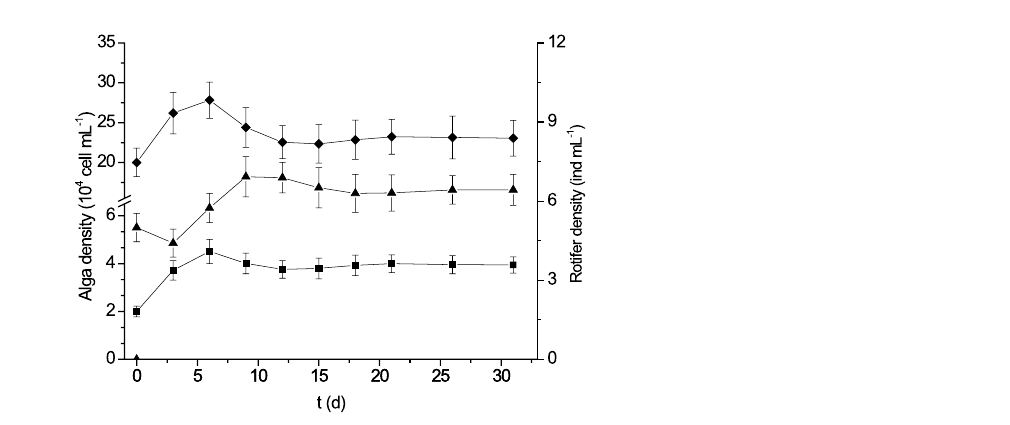
Figure 3. Plankton densities over time inthe unexposed customized plankton community toxicity test (the dots displaying were mean values and the error bars stood for standard deviations; ■ : P. subcordiformis ; ▲ : B. plicatilis